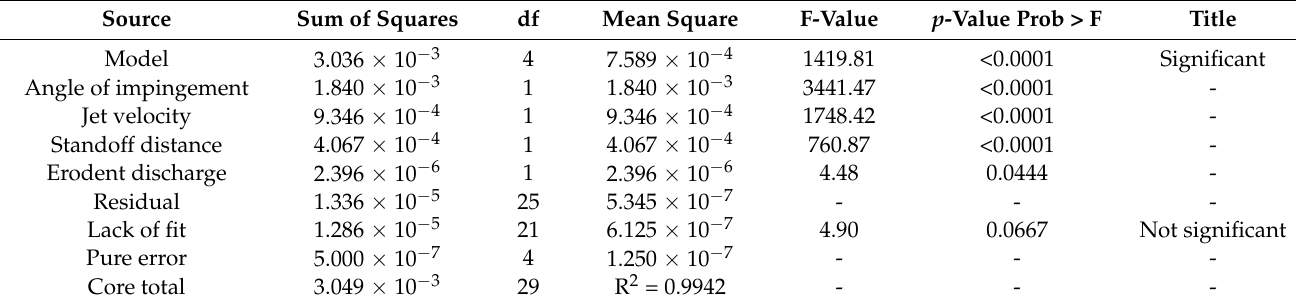
Table 6. ANOVA results for the coated stainless